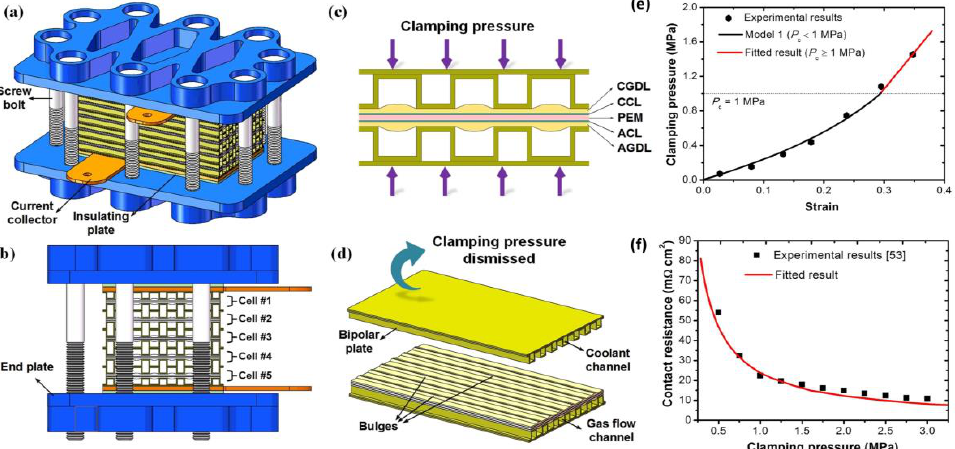
Figure 7. ( a , b ) Schematic of PEMFC showing the bolts and nuts; ( c ) diagram for what happens to the MEA when subjected to clamping pressure; ( d ) diagram for a unit cell; ( e ) clamping pressure and strain; ( f ) relationship between clamping pressure and contact resistance [134] (license no. 5175230250109).